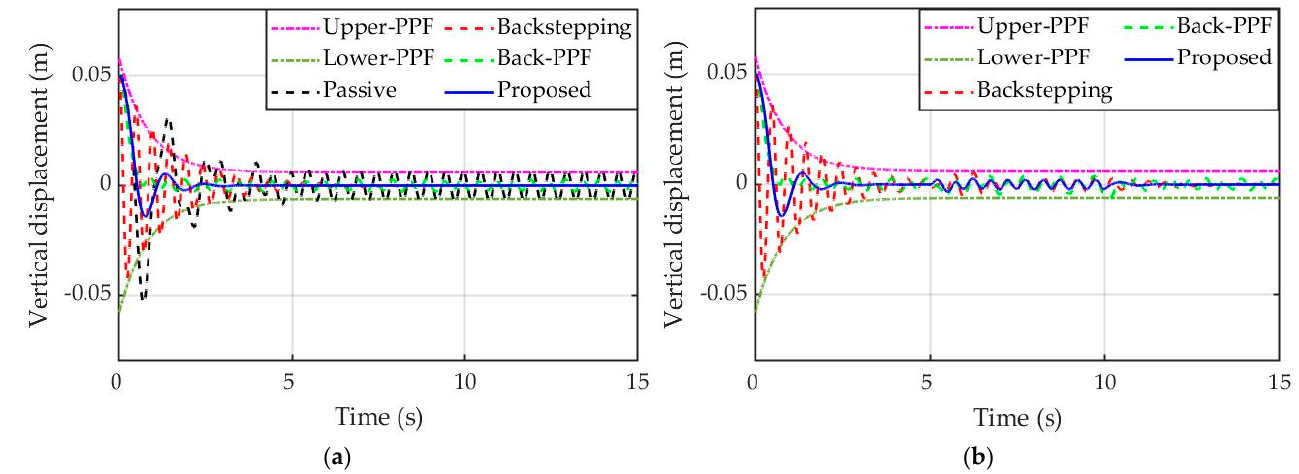
Figure 3. Sprung mass vertical displacement: ( a ) Non-fault; ( b ) Actuator-fault.